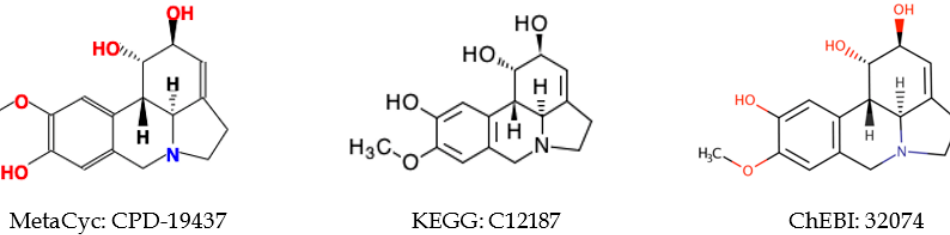
Figure 7. Example of inconsistent compound representations between KEGG and MetaCyc.